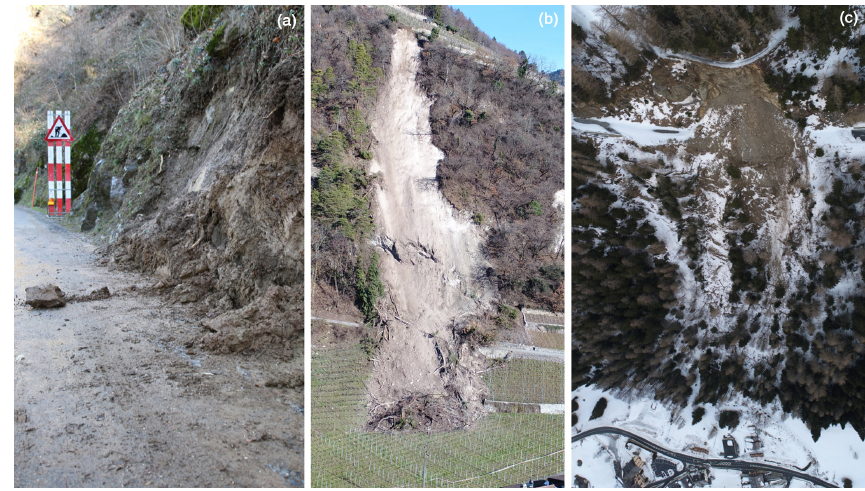
Figure 4. Examples of events affecting roads. (a) Small event on the only road to the small village of Morcles (canton of Vaud). (b) Middle- sized event on a minor road in Ollon (canton of Vaud). (c) Large event with an estimated volume of 3500m 3 that cut a 50m length on the international road between France and the canton of Valais near the Forclaz pass (Trient). The road closure was estimated at 6 weeks. Images taken on 24 January 2018 after a winter